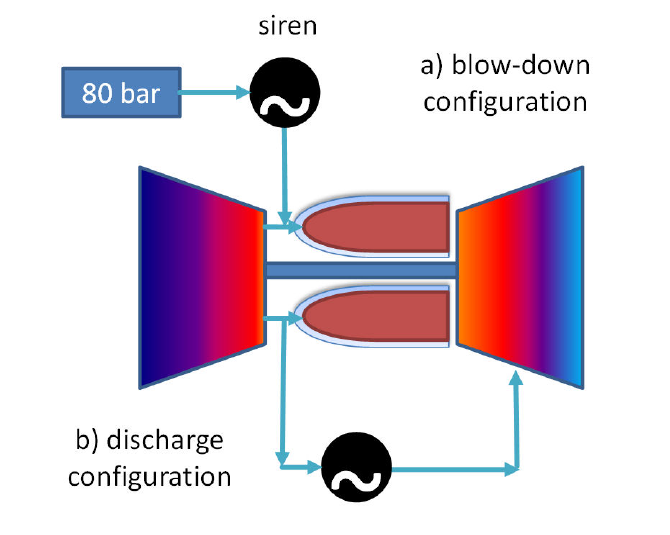
Figure 20. Possible implementations of a siren on a gas turbine for flow control [36]: ( a ) Blow-down and ( b ) discharge configurations.